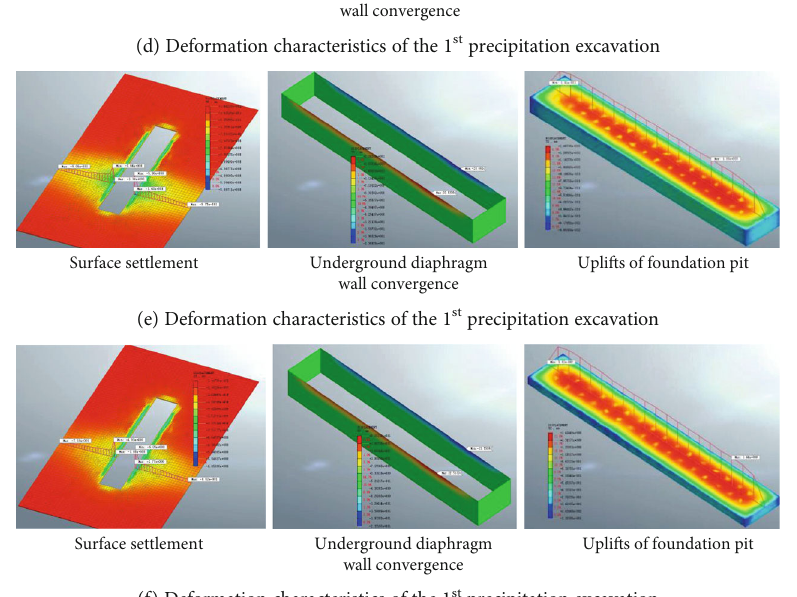
Figure 7: Deformation evolution of deep foundation pit precipitation